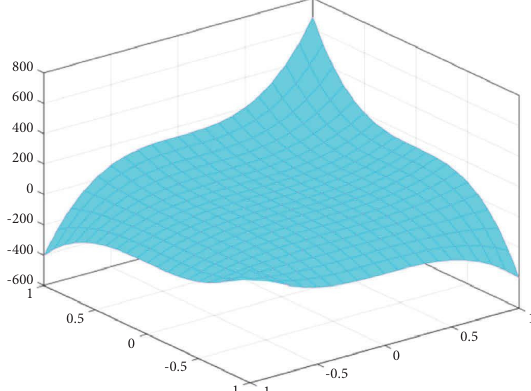
Figure 2: Te correlation of r and FN ∗ .